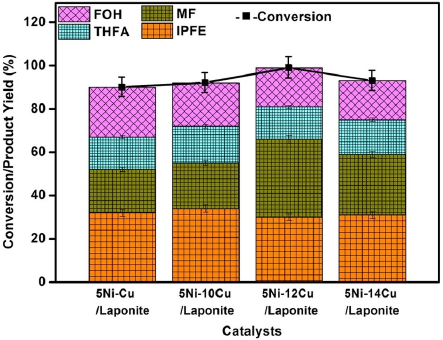
Figure 4. Furfural conversion and product yield over the catalysts at 190 °C for 4 h under 20 bar H 2 pressure (FOH = furfuryl alcohol, IPFE = isopropyl furfuryl ether). Reprinted with permission from [149]. Copyright 2022 Elsevier